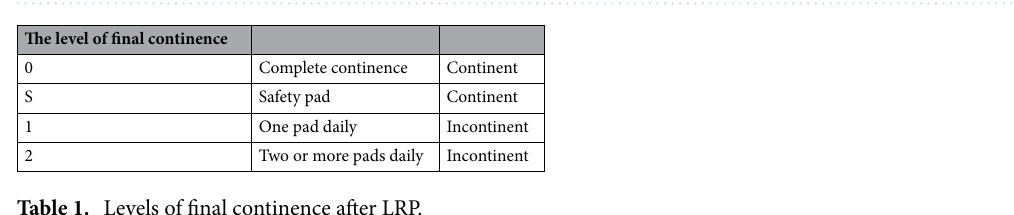
Figure 3. Transperineal ultrasound (TPUS) postoperative membranous urethra length (MULpost) measurement—left side, MULpost = 14.3 mm—patient incontinent at 12 months after surgery, right side, MULpost = 39.5 mm—patient continent at 1 month after surgery.